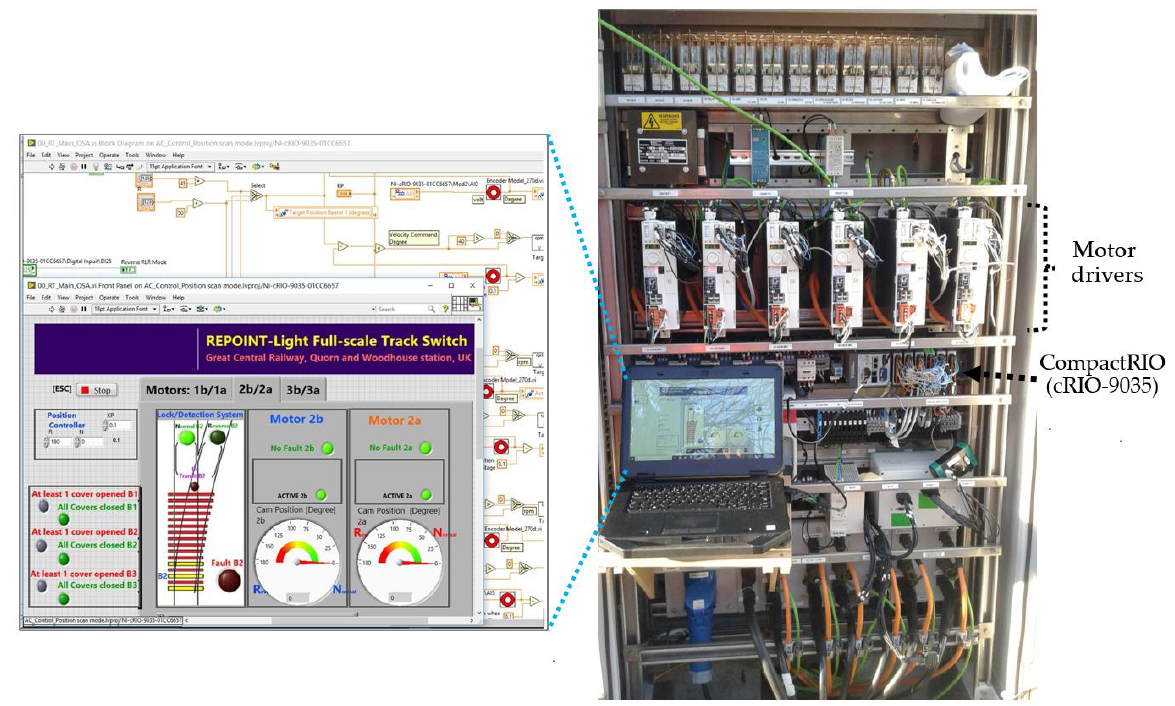
Figure 10. Location cabinet with hardware installed, for testing at Great Central Railway Quorn and Woodhouse Station, UK.